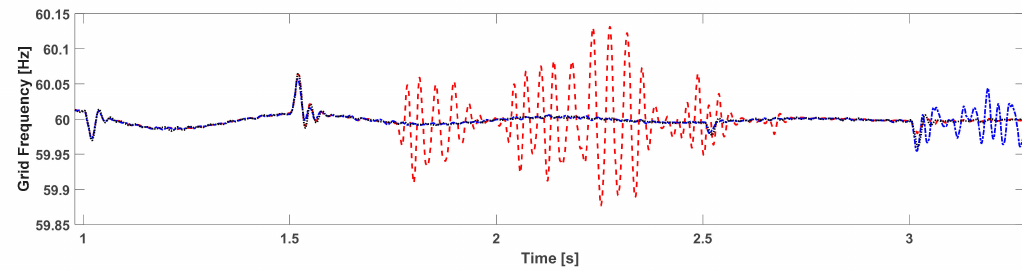
Figure 25. Measured frequency at 11 kV bus during faulty operation (80% power-loss